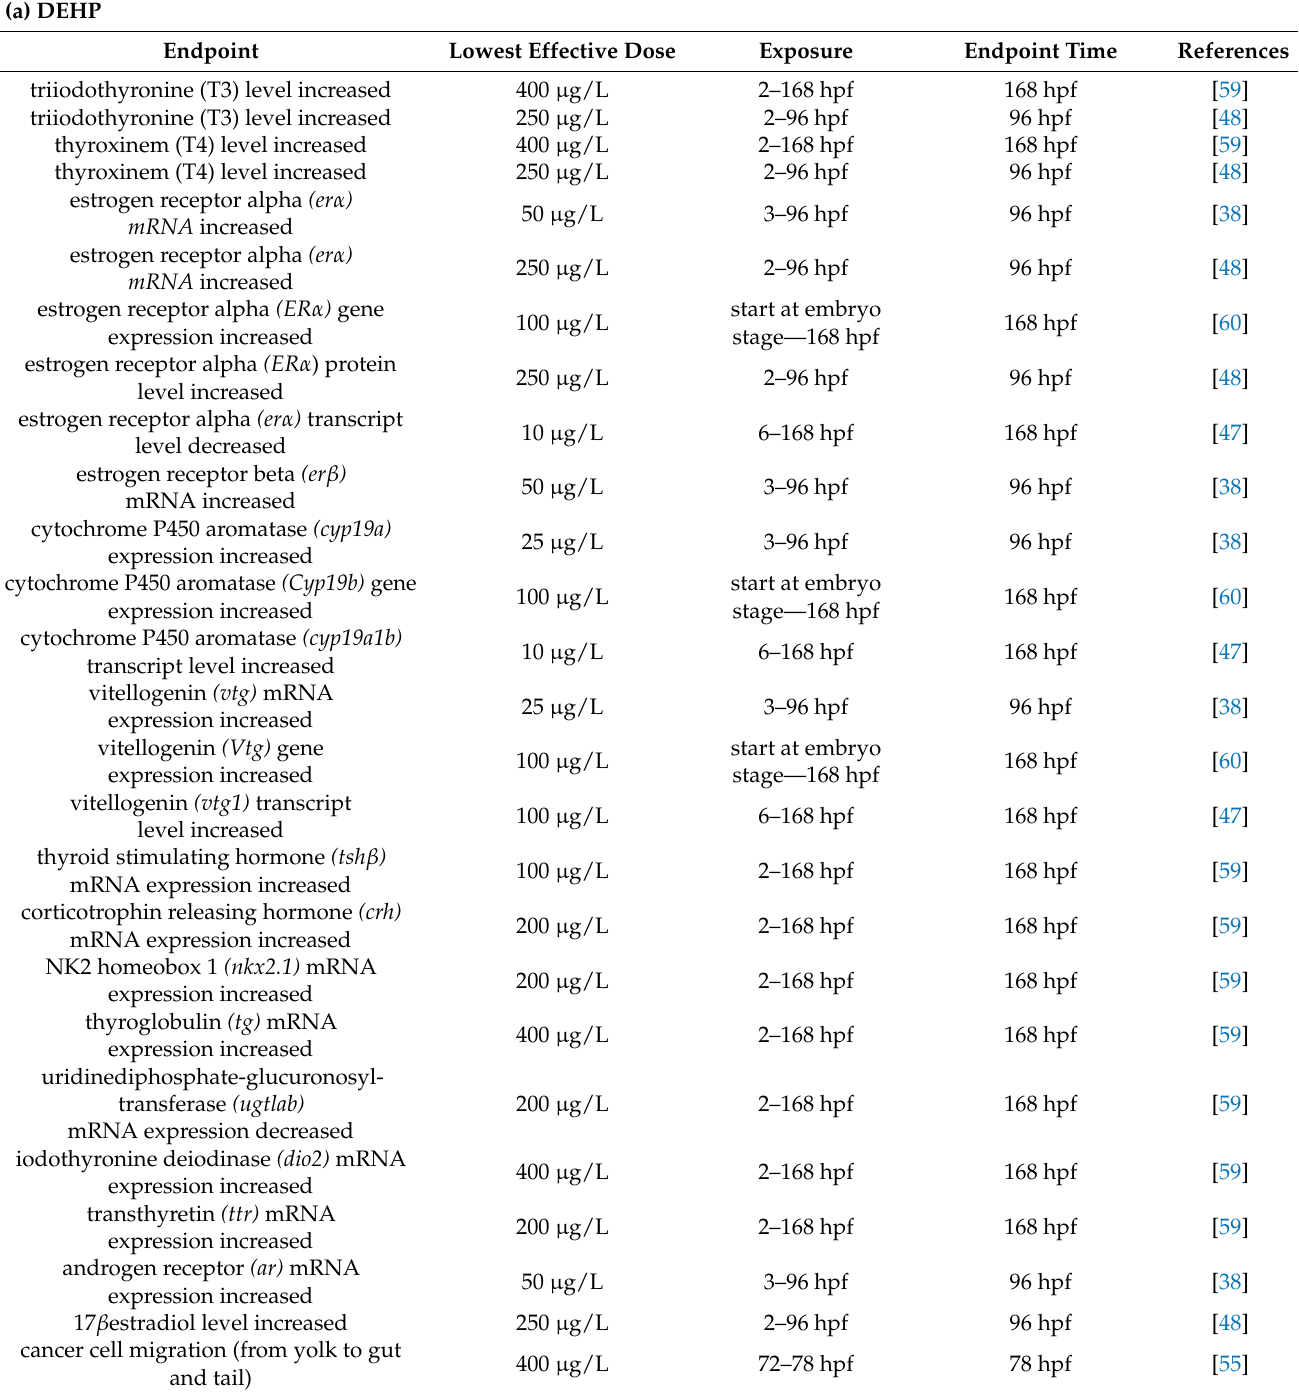
Table 10. Endocrine disruption from acute exposures to (a) DEHP and (b) MEHP in zebrafish embryos. ** The concentration was converted from nM or µ M using the molar mass of MEHP 278.34